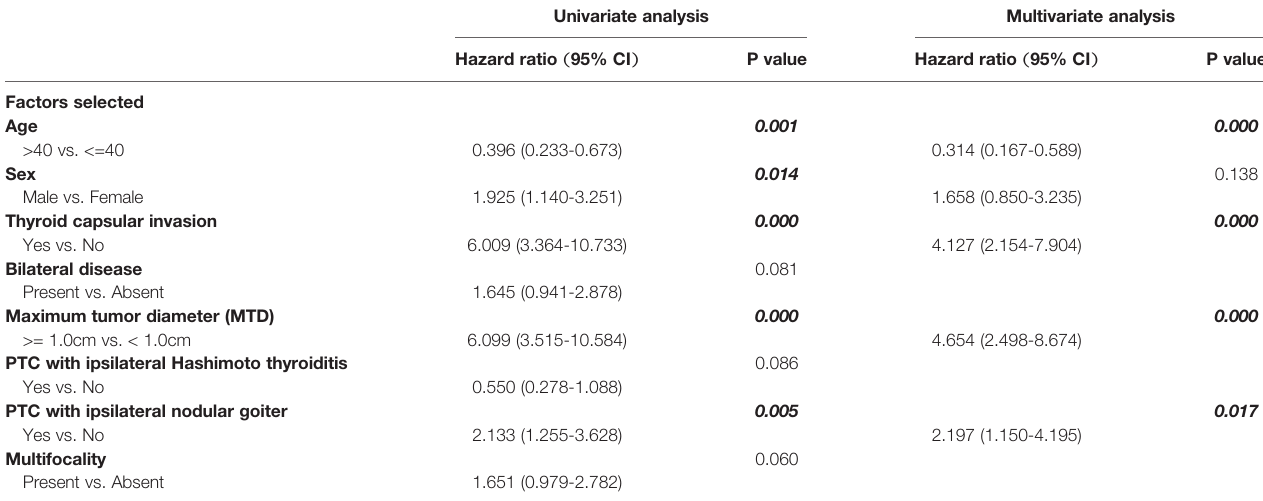
TABLE 4 | Univariate and multivariate analyses for tumor located in upper portion.